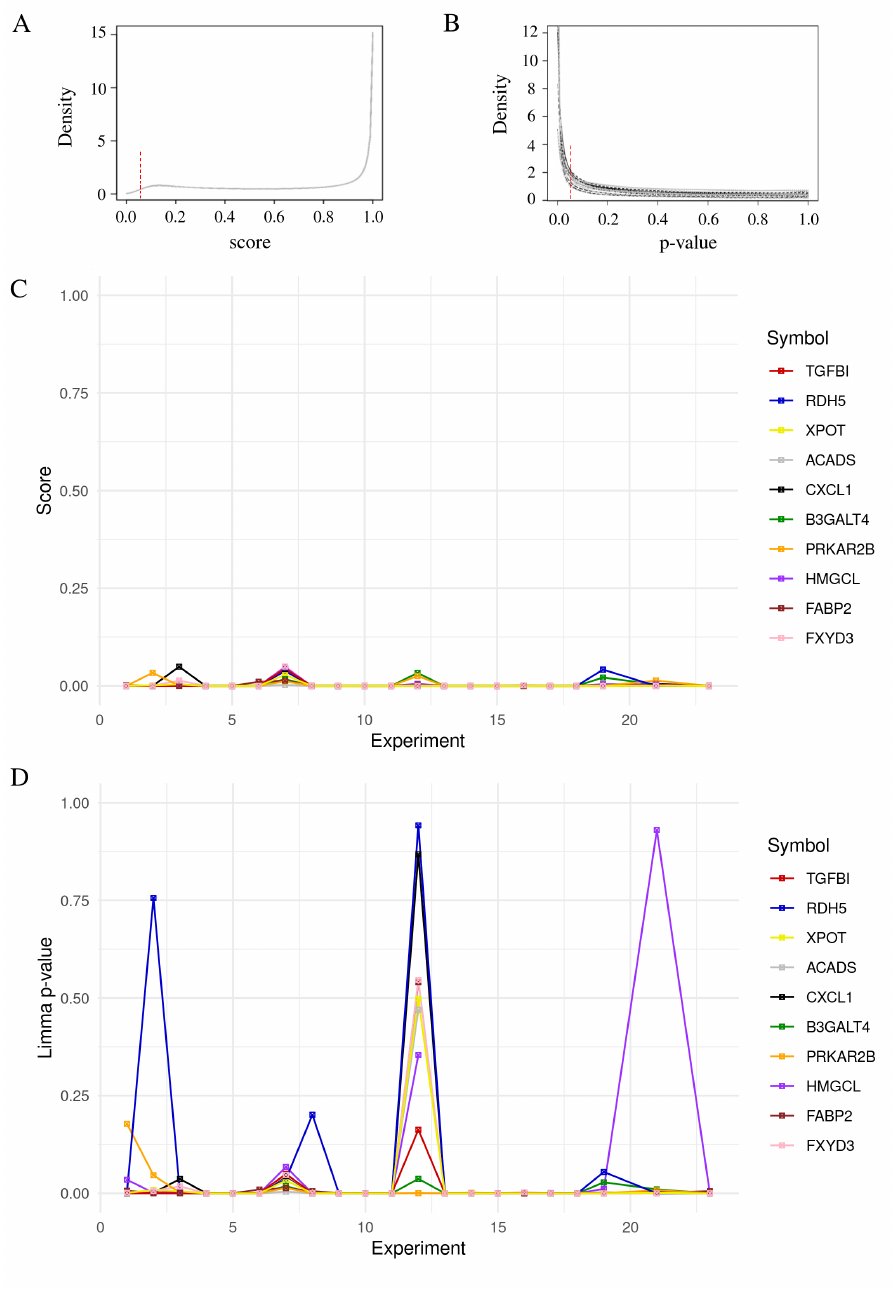
Figure 3. Comparison between common significant genes using the moderated p -value and our score. The 18 genes were reported with a score < 0.05 and with a moderated p -value < 0.05. The cut off for score ( A ) and moderated t -test ( B ) are indicated by the vertical red dashed line in the density plot. All genes were represented across the 21 datasets with the corresponding score ( C ) and p -value ( D